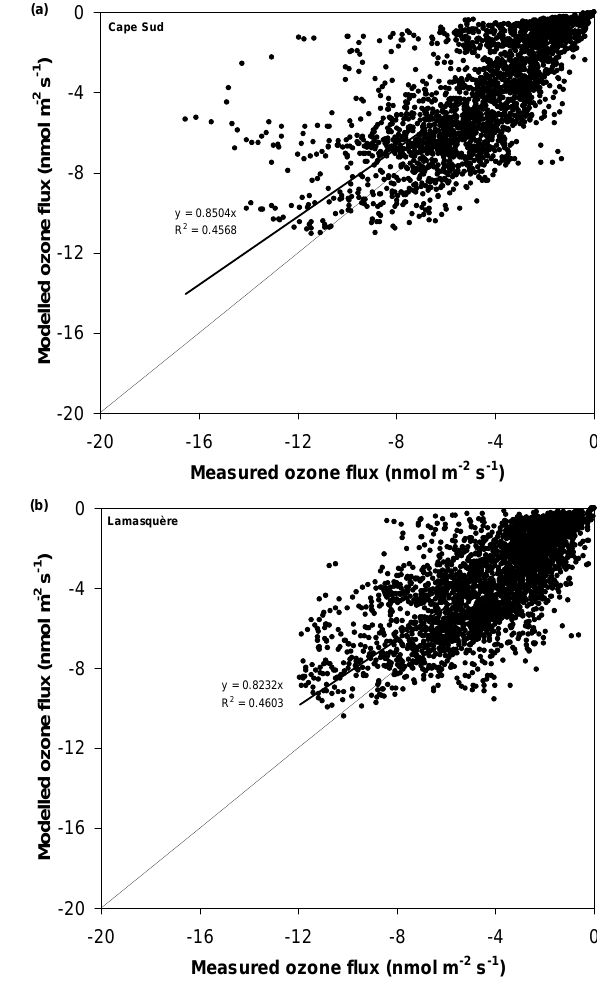
Figure 6: Comparison between measured and modelled (a) ozone and (b) latent heat fluxes 30 Fig. 6. Comparison between measured and modelled (a) ozone including (black symbols) and without including (grey symbols) stomatal conductance for 31 and (b) latent heat fluxes including (black symbols) and without yellow leaves in the model for the Grignon site during senescence (i.e. from 11 th July 2008 to 32 including (grey symbols) stomatal conductance for yellow leaves 9 th September 2008). Only data for u * > 0.1 m s -1 are represented. 33 in the model for the Grignon site during senescence (i.e. from 11 July 2008 to 9 September 2008). Only data for u ∗ > 0.1ms − 1 are represented.